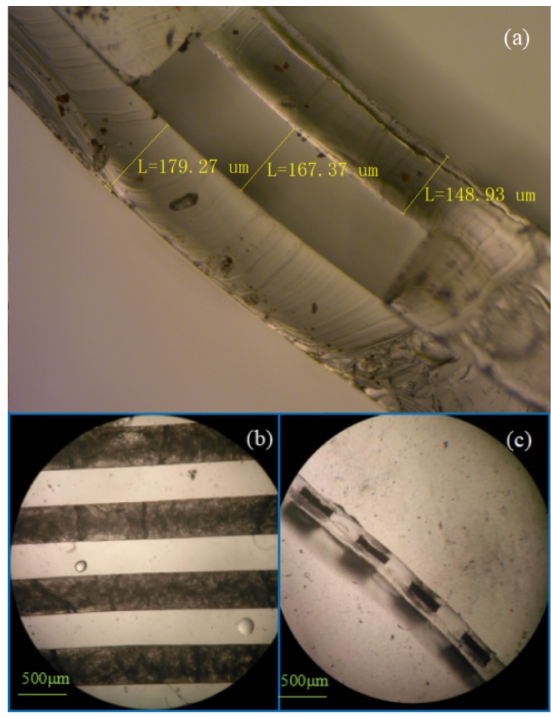
Figure 8. The PDMS-PDMS microchannels ( a ) before PCM filling; ( b , c ) after PCM filling.